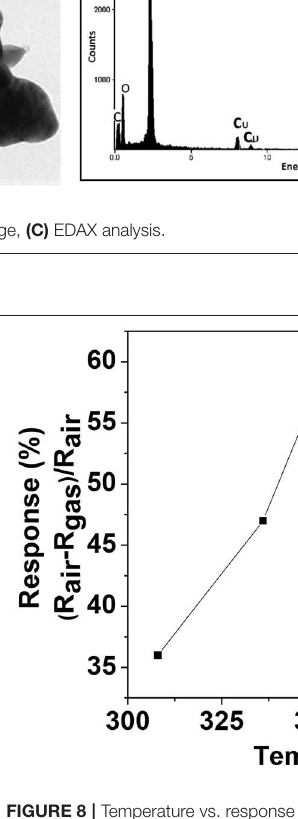
FIGURE 7 | IV-measurements of α -MoO 3 nanoparticles at room temperature, 270 ◦ C and 370 ◦ C. is a blue shift in this sample due to the decrease in particle size (Patil et al., 2011).